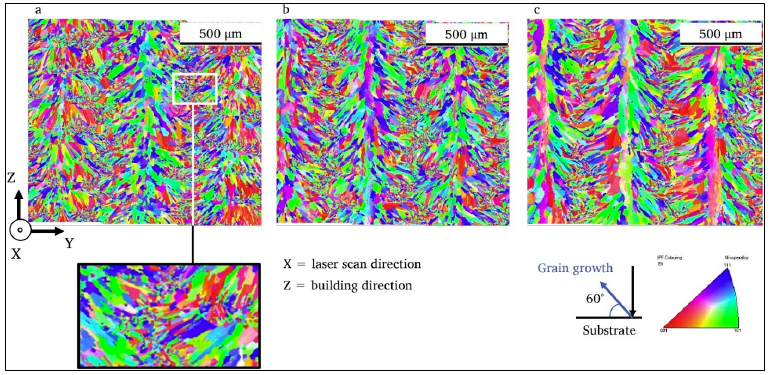
Figure 8. EBSD analyses of the DLD Inconel 625. Inverse pole figure (IPF) of the Y-Z (transverse) section of samples printed with different laser power. ( a ) 270 W; ( b ) 300 W; ( c ) 330 W (adapted with permission from Ref. [24] 2019, Elsevier).